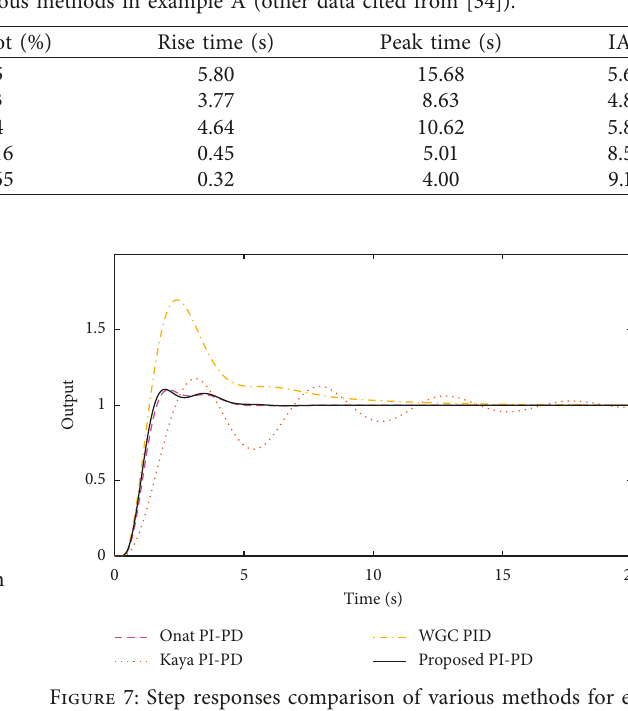
Figure 17. Compared with Onat’s method, the method proposed in this paper can achieve faster response.